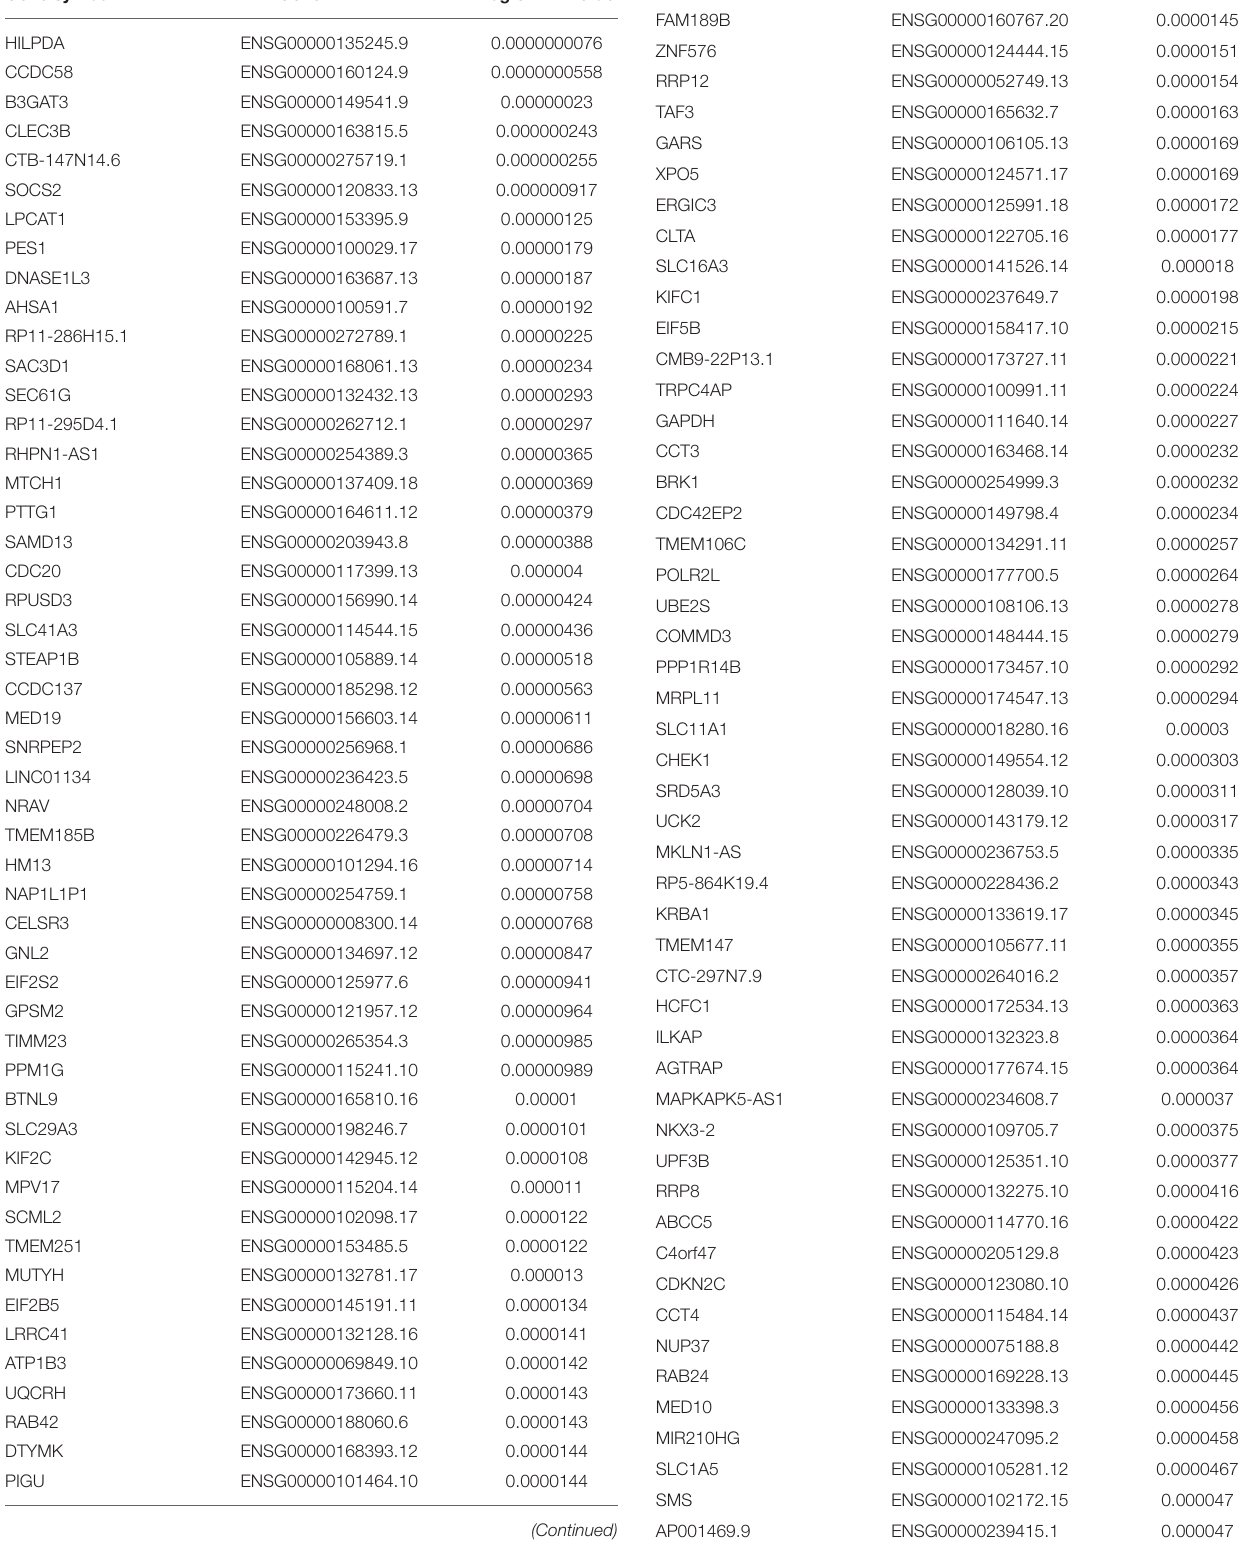
TABLE 1 | The genes most associated with overall survival (OS) of patients with hepatocellular carcinoma determined by GEPIA